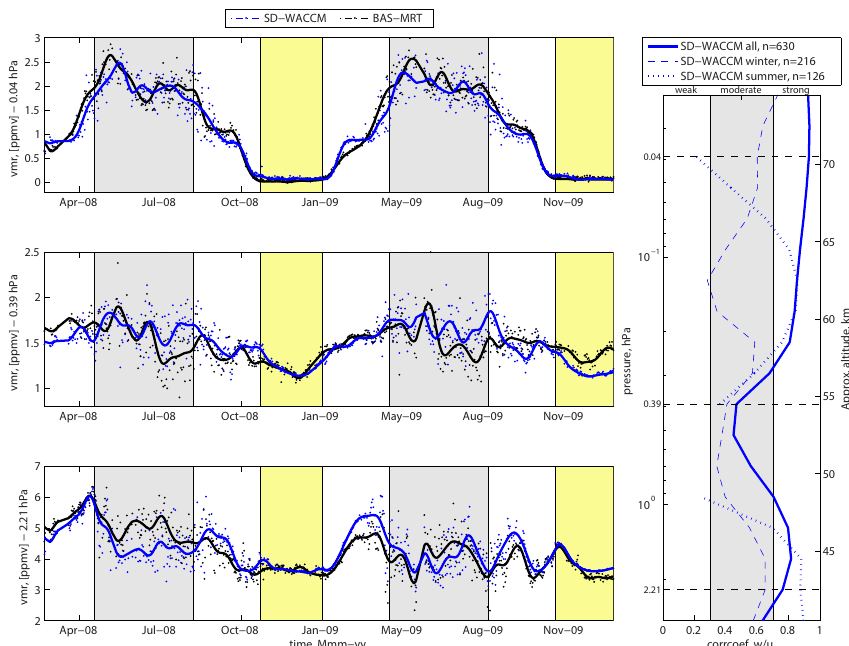
Figure 7. Same as Fig. 6, but for BAS-MRT and SD-WACCM. Data are from midnight only.